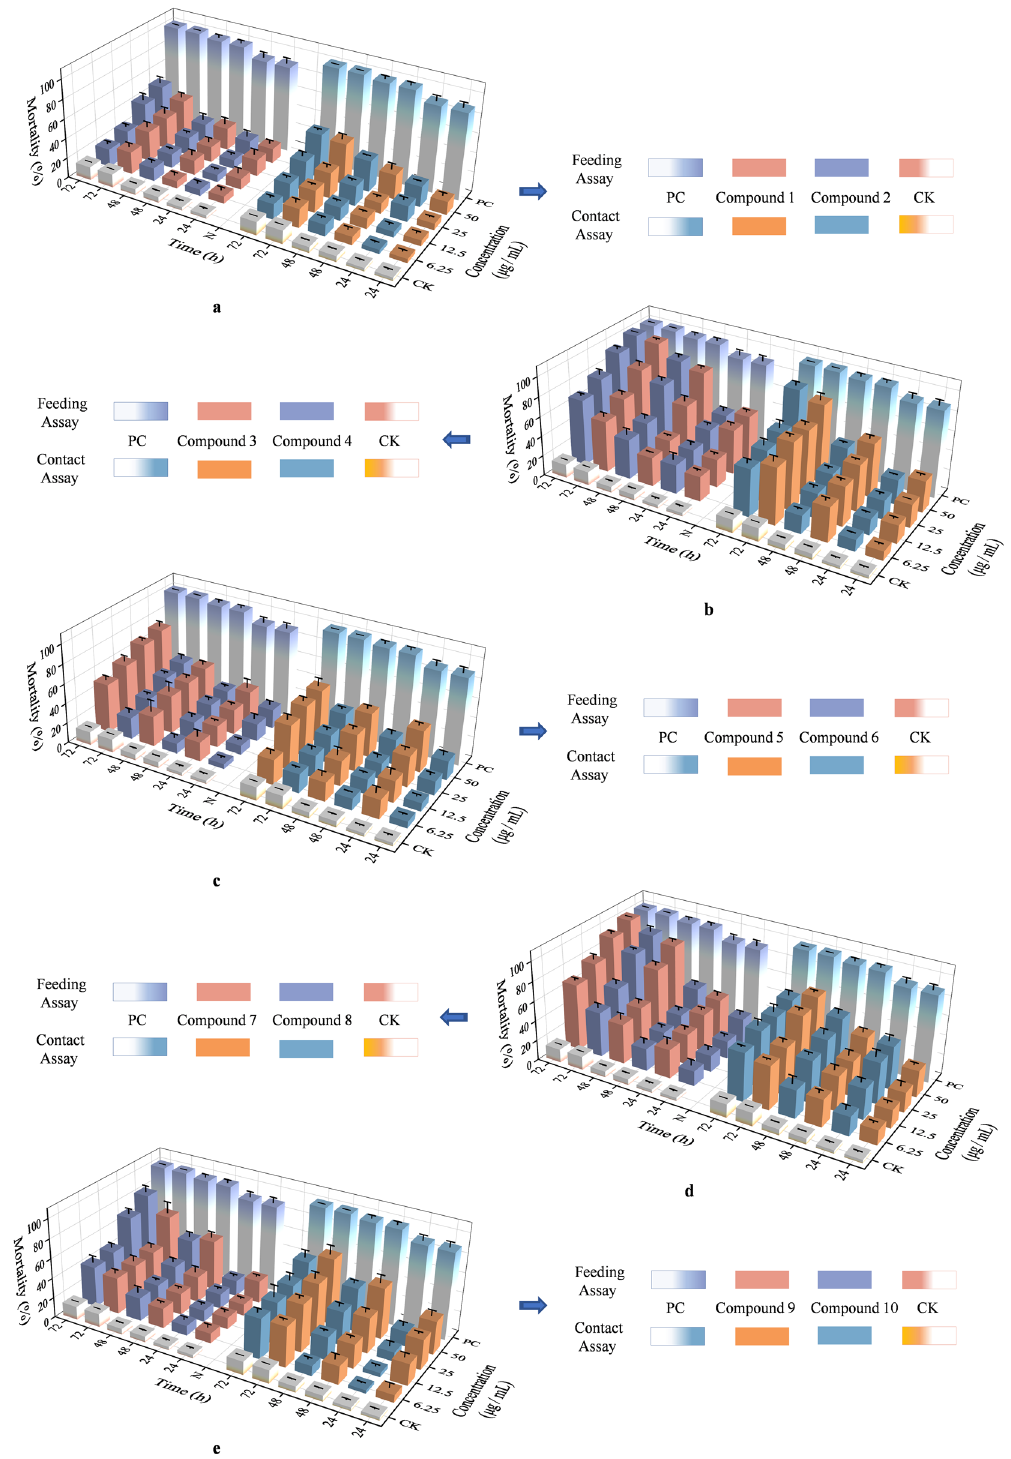
Figure 3. The morality rate of compounds 1–10 with different concentrations and assay methods at 24 h, 48 h and 72